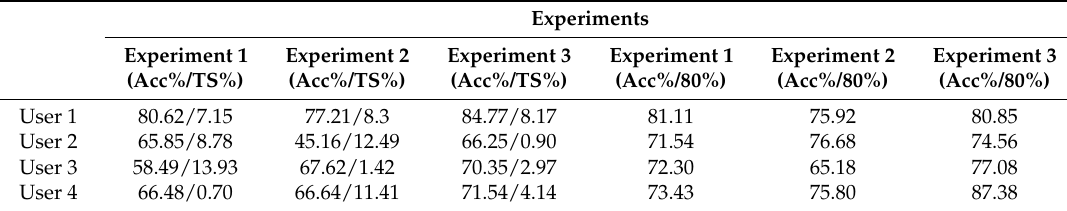
Table 4. Classification performance obtained from IMU and 3-axial acceleration